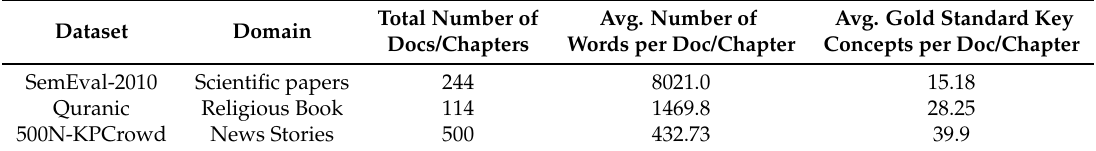
Table 1. Statistics of the datasets